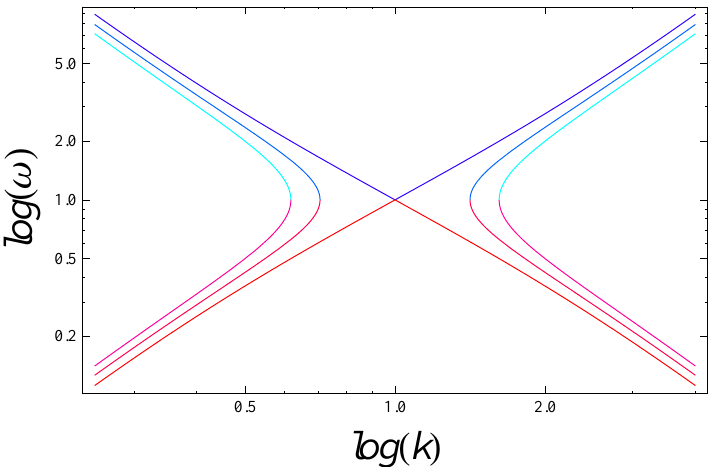
Figure 3. ω + ( k : m ) (blue) and ω − ( k : m ) (red), as a function of k , for two mass values in the range m < m (cid:48) (or, equivalently, their duals in the range m > m (cid:48) P In this and all subsequent plots, we choose units such that ω P = k P = 1,